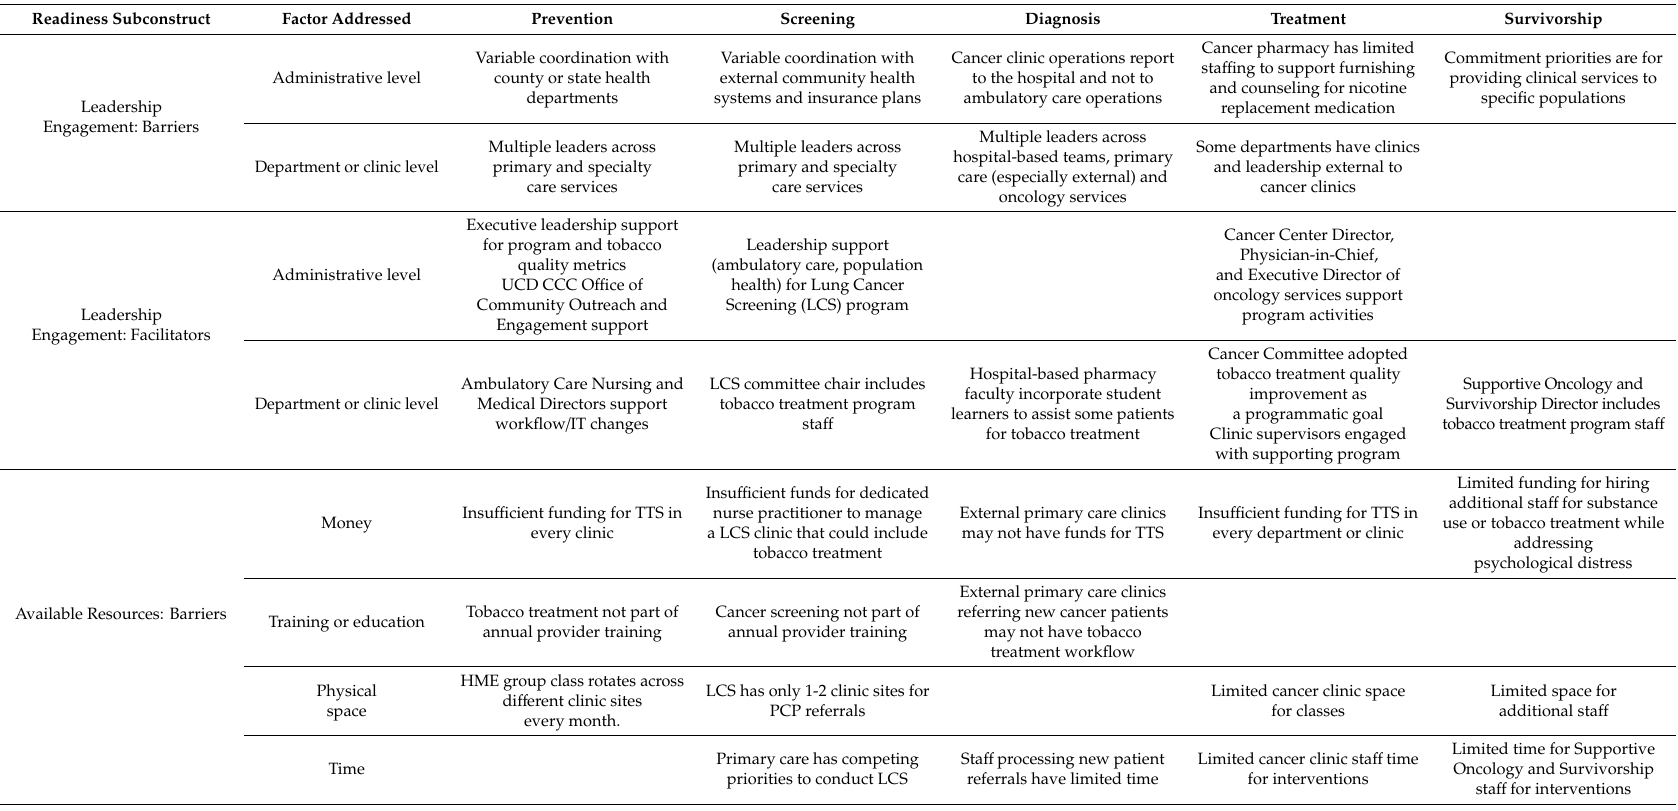
Table 1. Three Subconstructs of Implementation Readiness for Tobacco Treatment with Barriers and Facilitators across the Cancer Care Continuum, UC Davis Health. Readiness